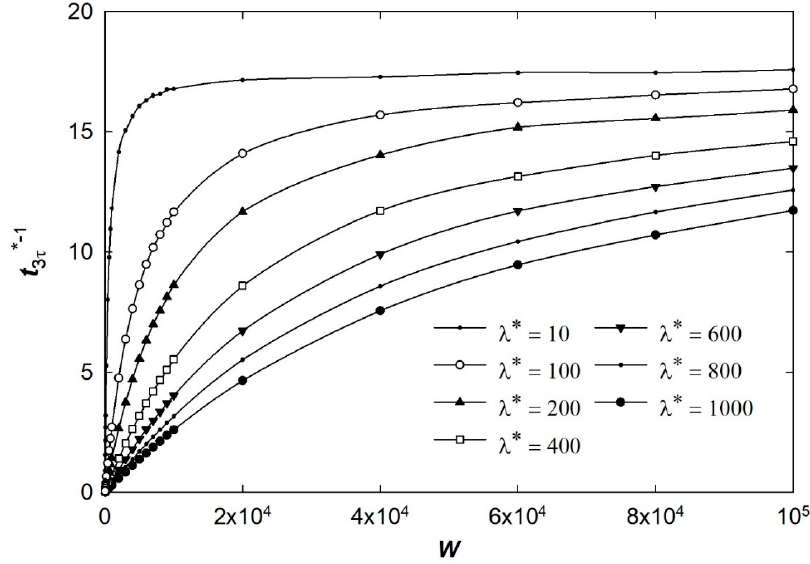
Figure 11. Reciprocal dimensionless time at the three times characteristic time τ of the process at x * = 0.75 versus dimensionless anchoring energy for different ranges of dimensionless surface viscos- ity.